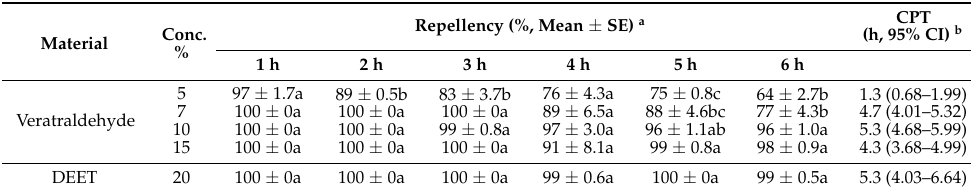
Table 3. Repellency and CPT based on the concentrations of veratraldehyde against Aedes albopictus females using the arm-in-cage